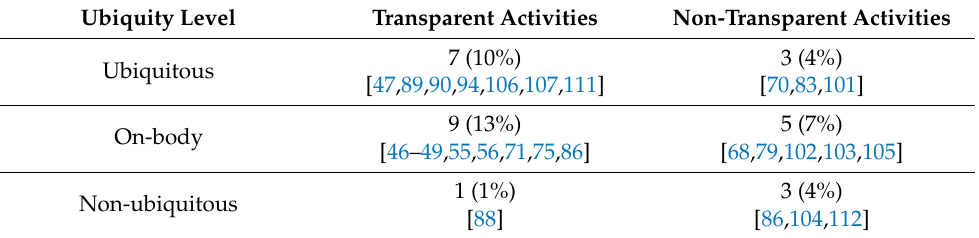
for the corresponding studies. The figures in brackets represent the percentage with respect to all 67 studies in the review.